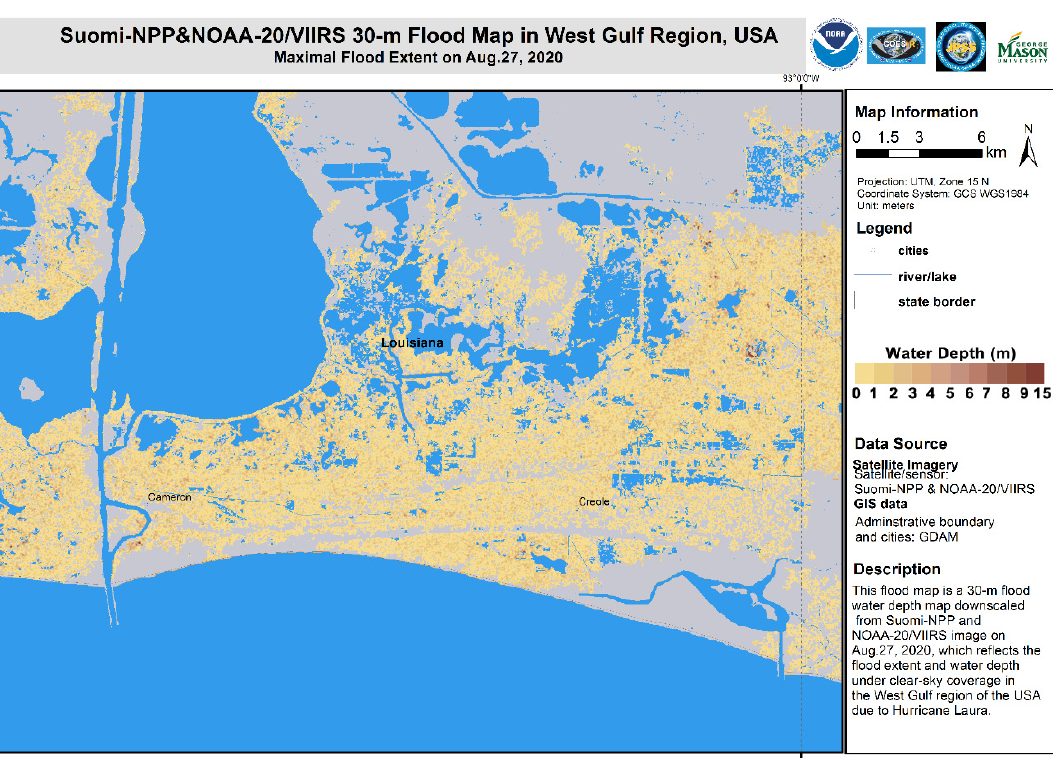
Figure 8. The 3D view of VIIRS downscaled 30 m floodwater depths in the West Gulf region due to Hurricane Laura on 29 August 2020.